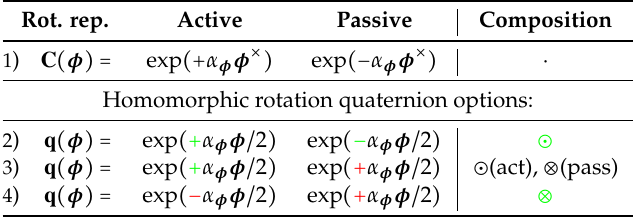
Table 3. Active vs. passive usage given a rotation vector φ